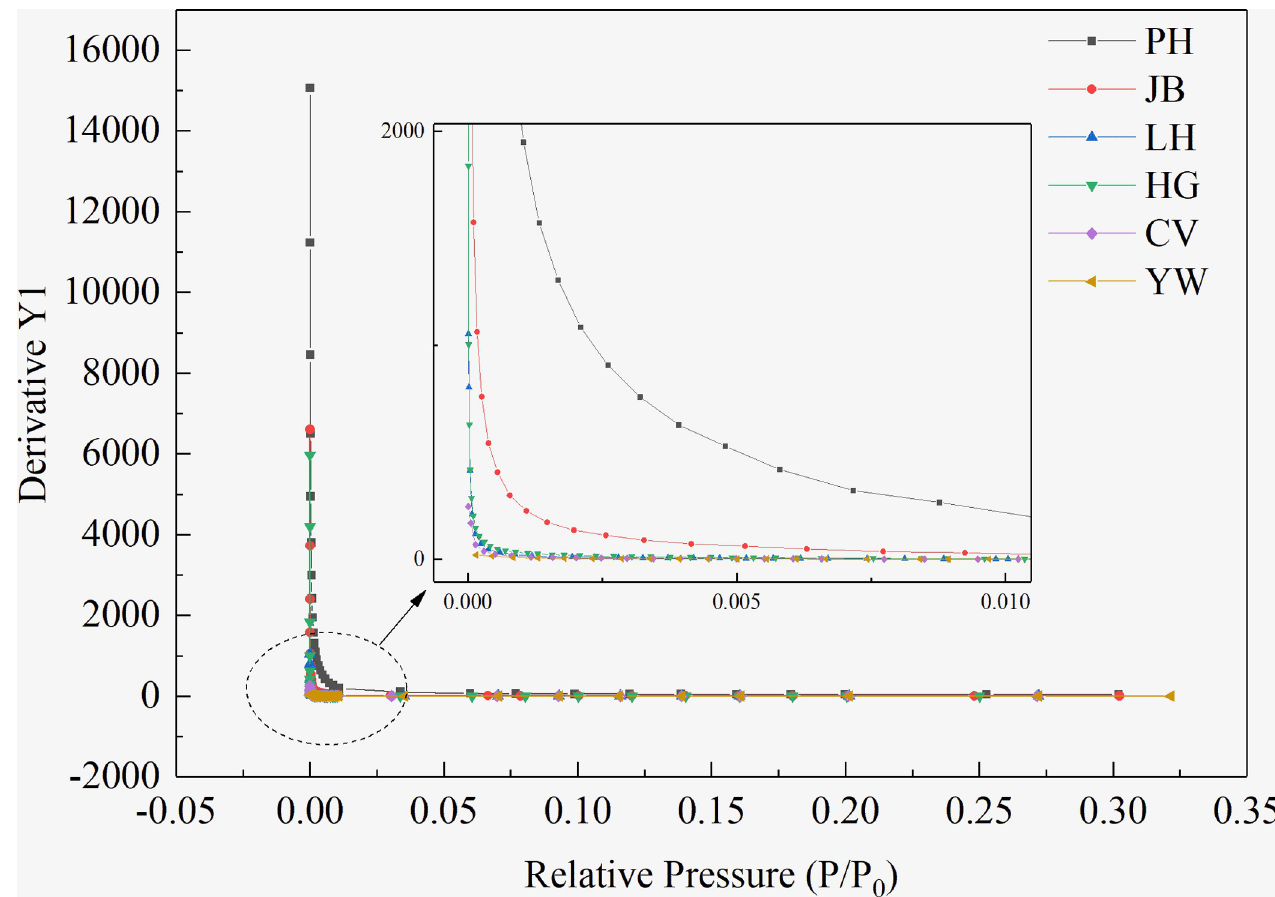
Fig 4. Differential curves of the adsorption isotherms of coal samples of different coal ranks.